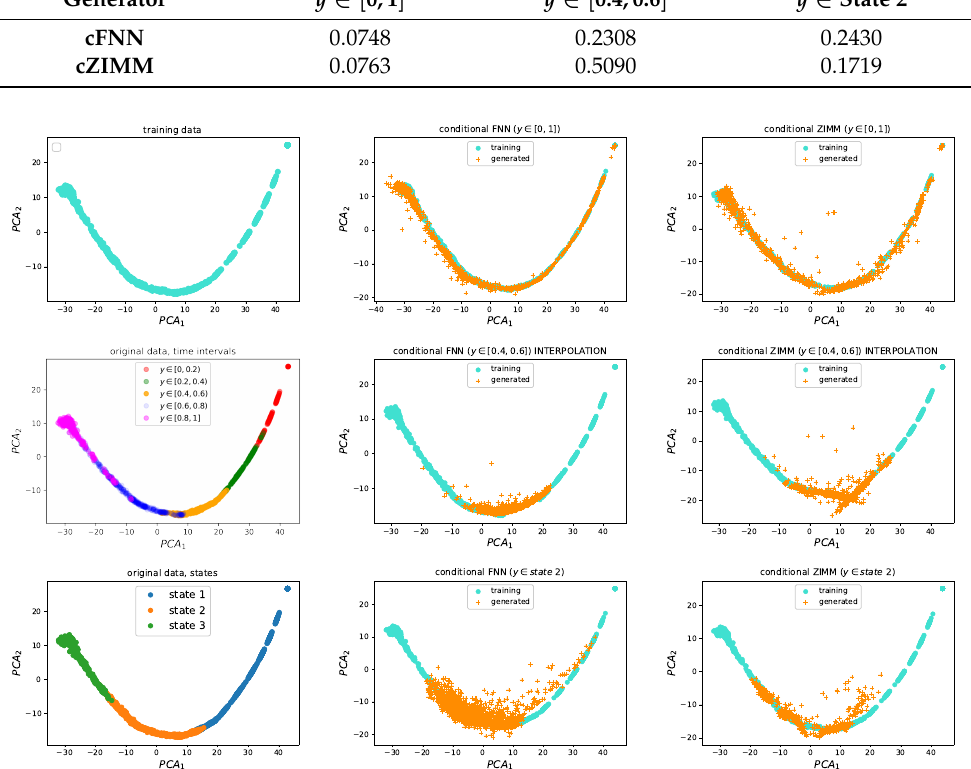
Table 1. MMD computations using FNN and ZIMM for σ = 5 in the RBF kernel, for experiments in Figure 4. Reference is the average MMD over the test set and 50 randomly chosen equally-sized training sets and is equal to & 0.015 ± 0.005. Lower MMD value is preferable.